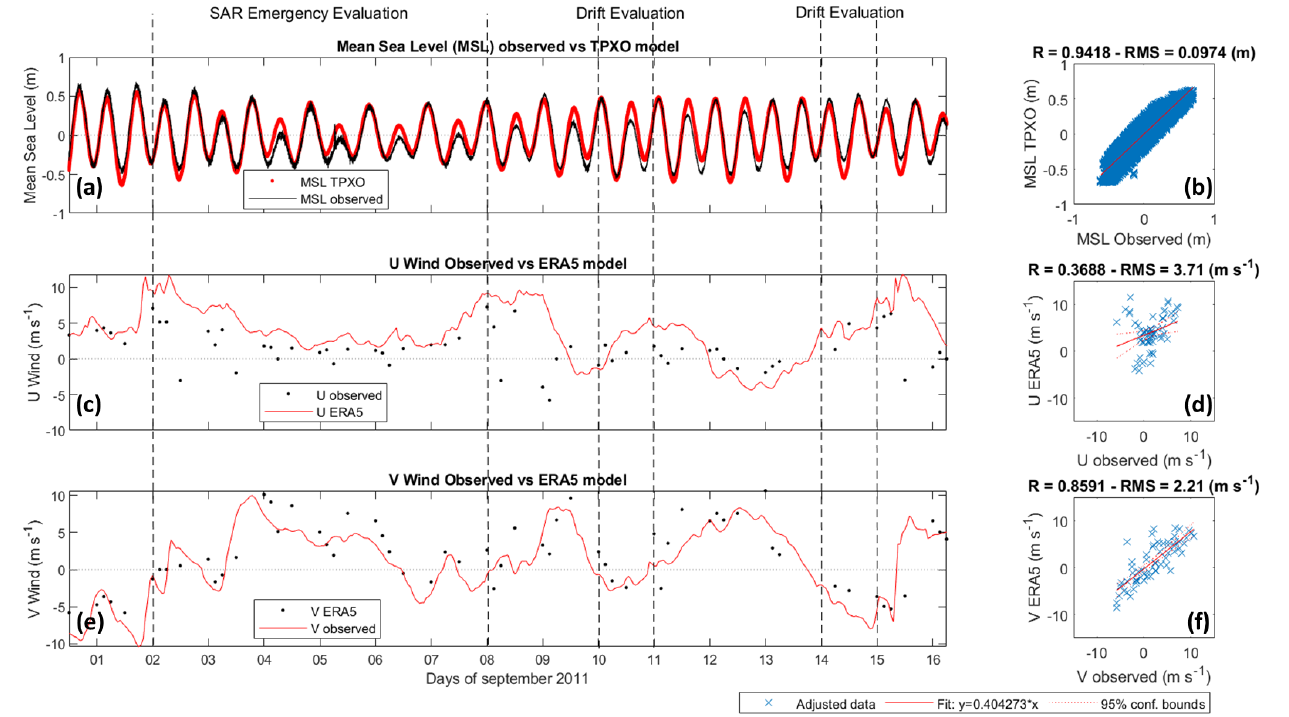
Figure 4. Open boundary forcings incorporated into FVCOM. ( a , b ) TPXO tidal model and measured tidal elevation at Cumberland Bay (SHOA), ( c , d ) Interpolated U wind component from ERA5 and measured U wind speed at Cumberland Bay station (DGAC). ( e , f ) Interpolated V wind component from ERA5 and measured V wind speed at Cumberland Bay station